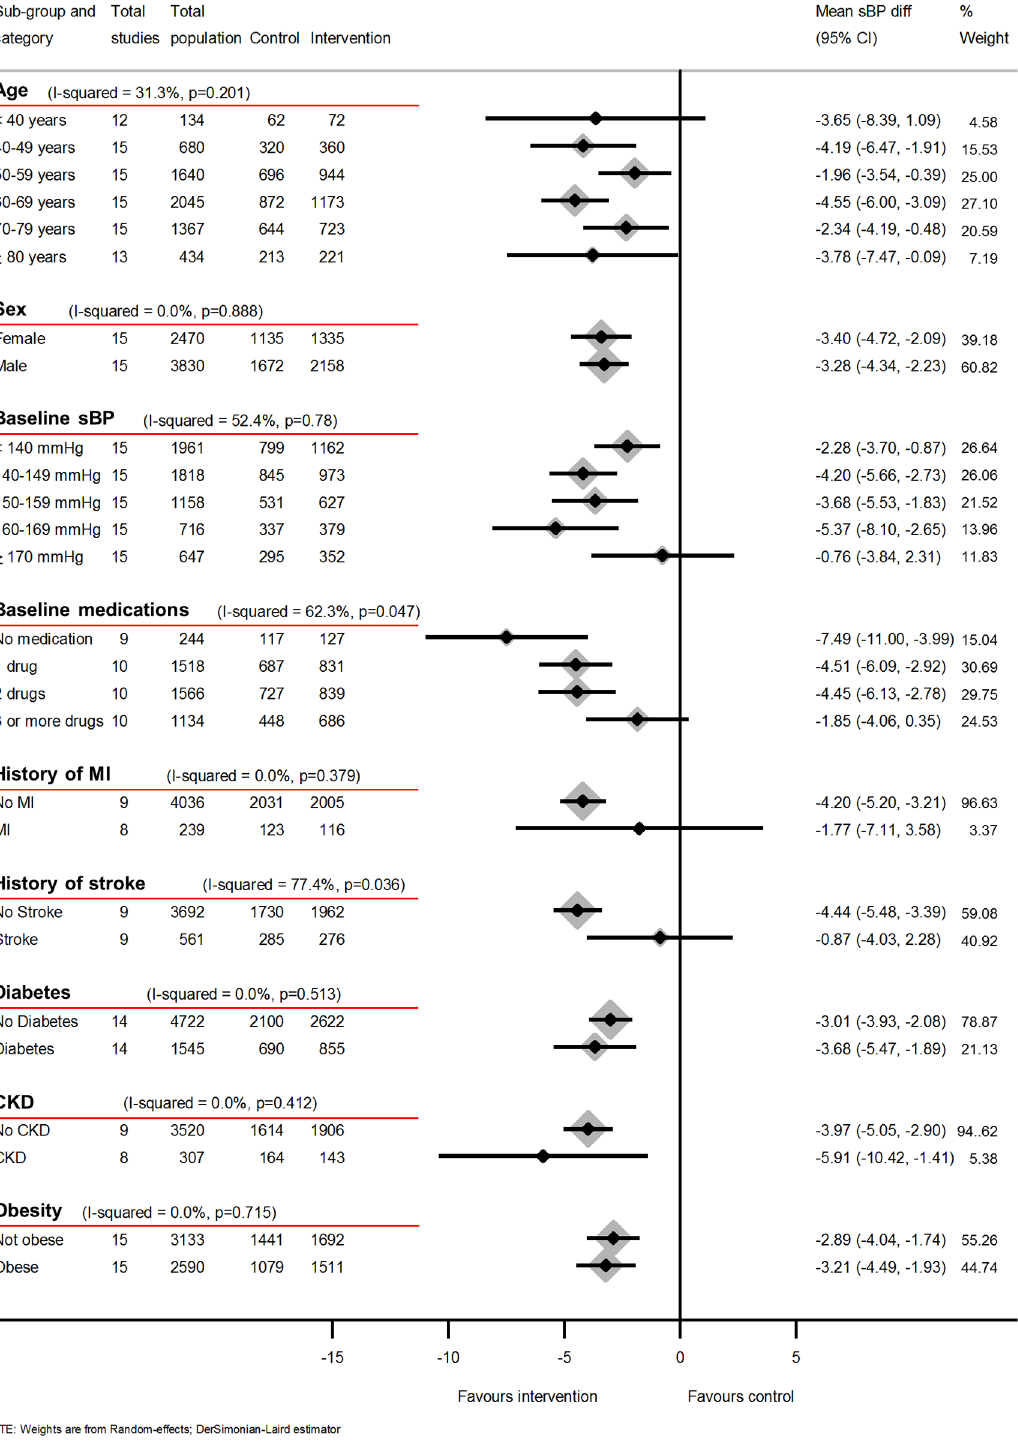
PLOS Medicine| https://doi.org/10.1371/journal.pmed.1002389 September 19,